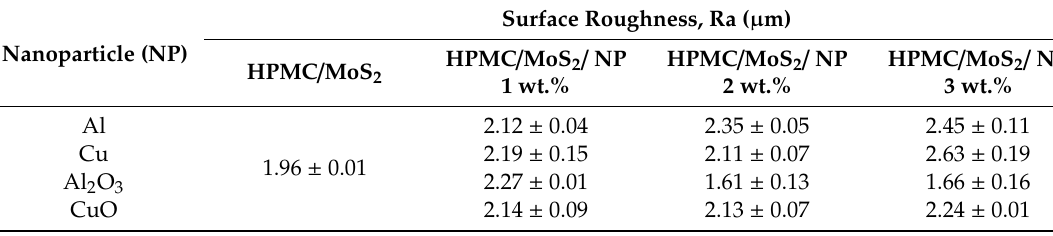
Table 2. Surface roughness (Ra) of HPMC / MoS2 /